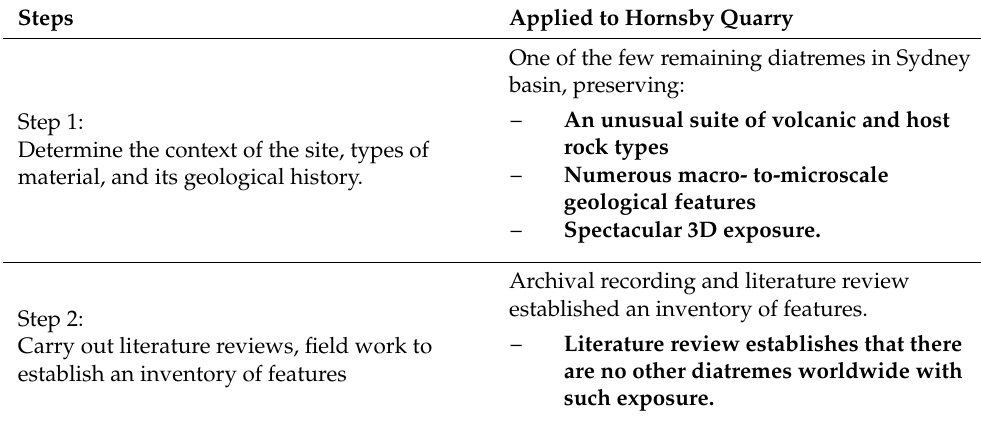
Table 1. Steps involved in geoheritage assessment of Hornsby Quarry, following the method outlined in Brocx and Semeniuk [18]). Bolded entries highlight attributes that are of international